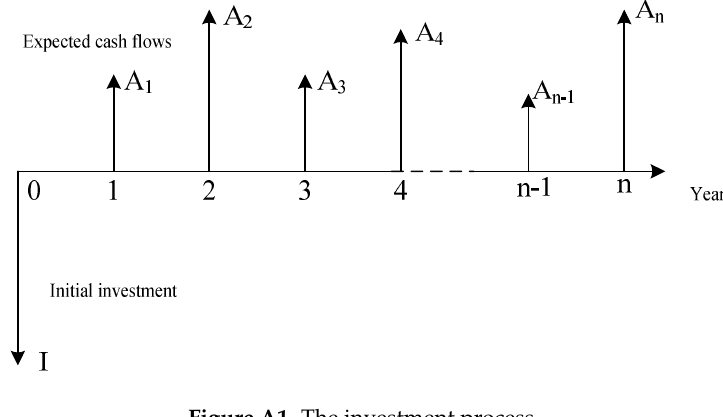
Figure A1. The investment process.